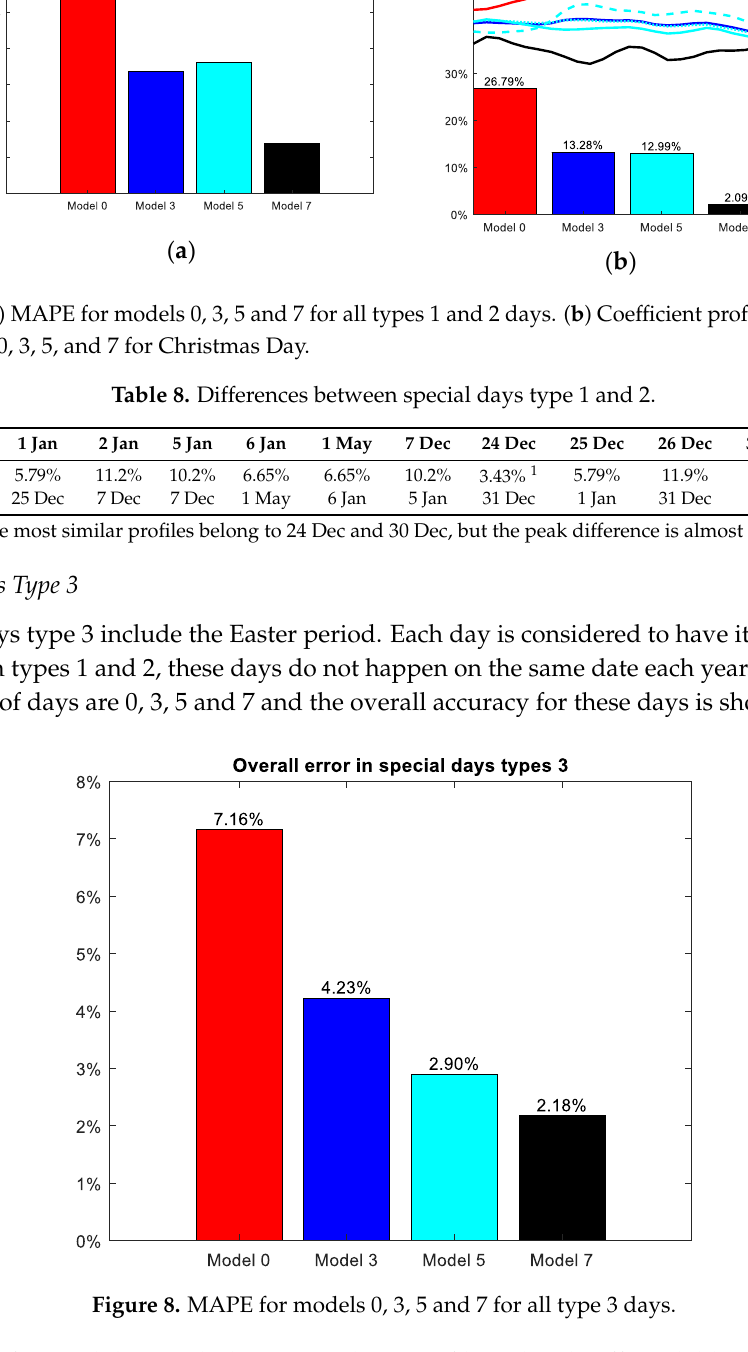
Figure 7. ( a ) MAPE for models 0, 3, 5 and 7 for all types 1 and 2 days. ( b ) Coefficient profile and MAPE for models 0, 3, 5, and 7 for Christmas Day.